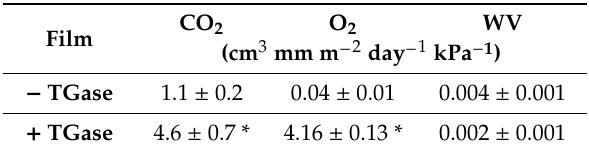
Figure 6. Absorbance and transmittance of films obtained from Nigella sativa defatted seed cake ( Ns DSC) at pH 8.0 with 20% glycerol (GLY) after incubation of film forming solutions (FFSs) in the absence or presence of transglutaminase (TGase, 20 U / g protein). Further experimental details are given in the text. Table 2. Gas and water vapor (WV) barrier properties of 20% glycerol (GLY)-containing protein concentrate (PC, 400 mg) films obtained at pH 8.0 after film forming solutions (FFS) incubation in the absence or presence of transglutaminase (TGase, 20 U / g protein). Further experimental details are given in the